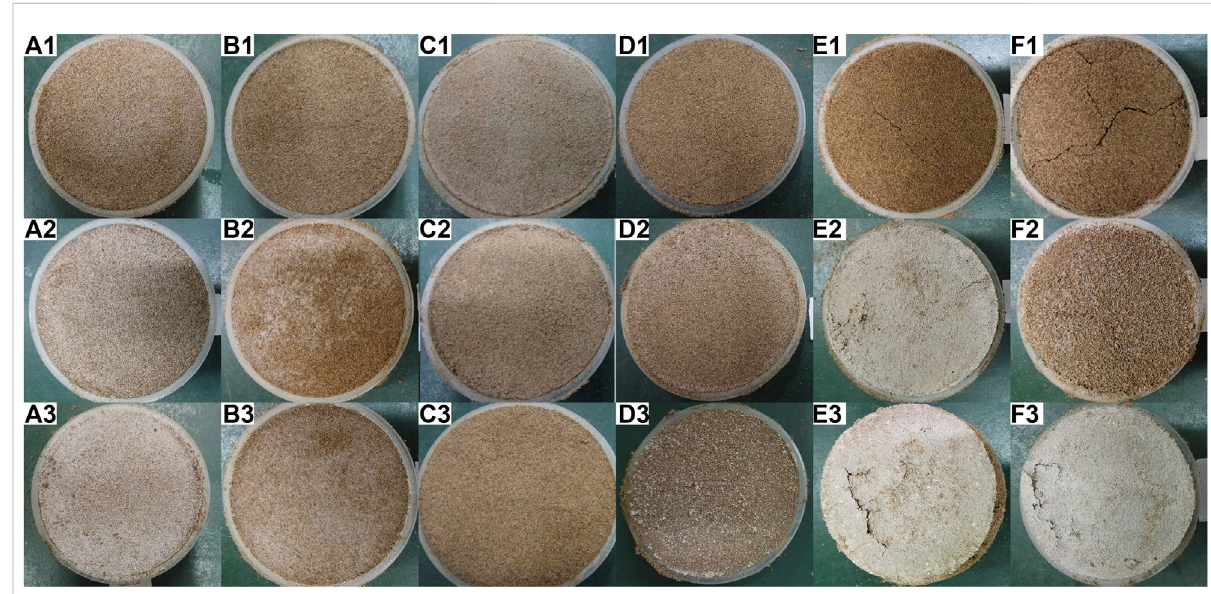
FIGURE 1 Apparent morphology ofsaltcrusts (A, B,C, D,E, and Frepresent CaCl 2 , KCl, Na 2 SO 4 ,NaCl,Na 2 CO 3 , and NaHCO 3 six kindsof salt, respectively; 1, 2, and 3 indicate salt content of 0.2, 1, and 4%